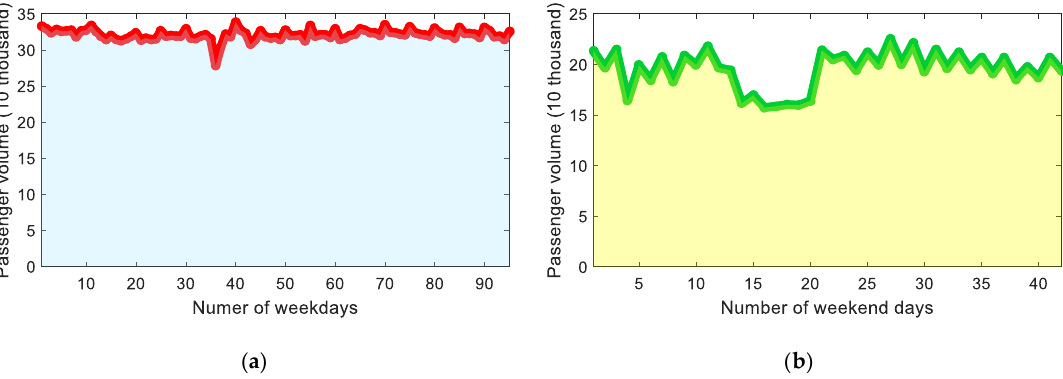
Figure 7. Statistical results of daily passenger volume in weekdays and weekend days. ( a ) Results in weekdays; ( b ) Results in weekend days.